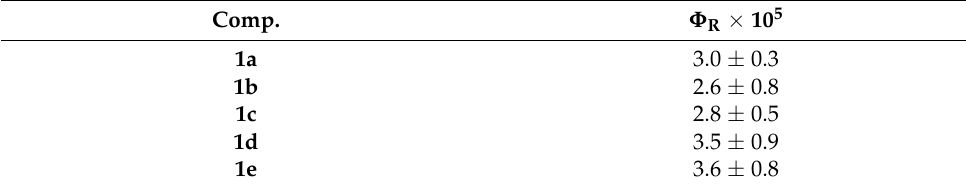
Table 2. Quantum yields ( Φ R ) of the photomethanolyses of 1 in CH 3 OH-H 2 O (4:1 v / v ) a .